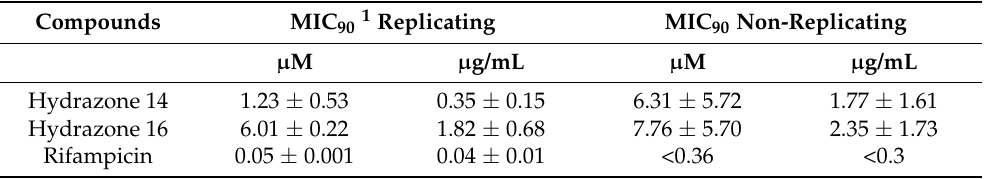
Table 1. Minimum inhibitory concentration (MIC 90 ) of hydrazones and control drugs against My- cobacterium tuberculosis in a replicating and non-replicating metabolic